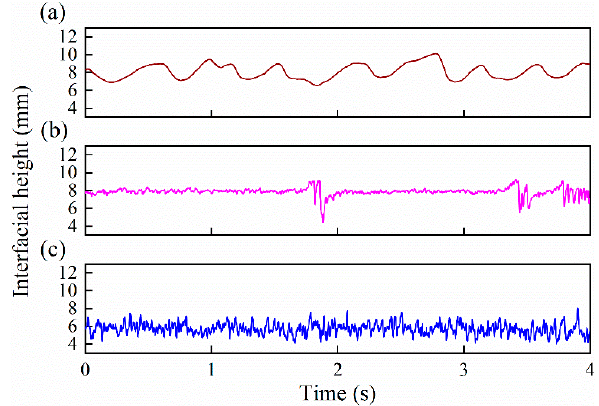
Figure 20. Time series of the interfacial height under typical flow conditions (0°): ( a ) U sw = 0.184 m/s, U so = 0.162 m/s, ST; ( b ) U sw = 0.368 m/s, U so = 0.552 m/s, ST&MI; ( c ) U sw = 0.737 m/s, U so = 0.921 m/s, D W/O&D O/W.